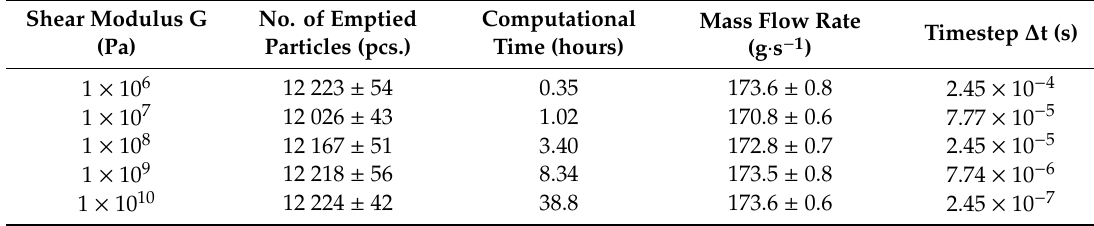
Table 13. Mass flow rate with di ff erent shear modulus value.